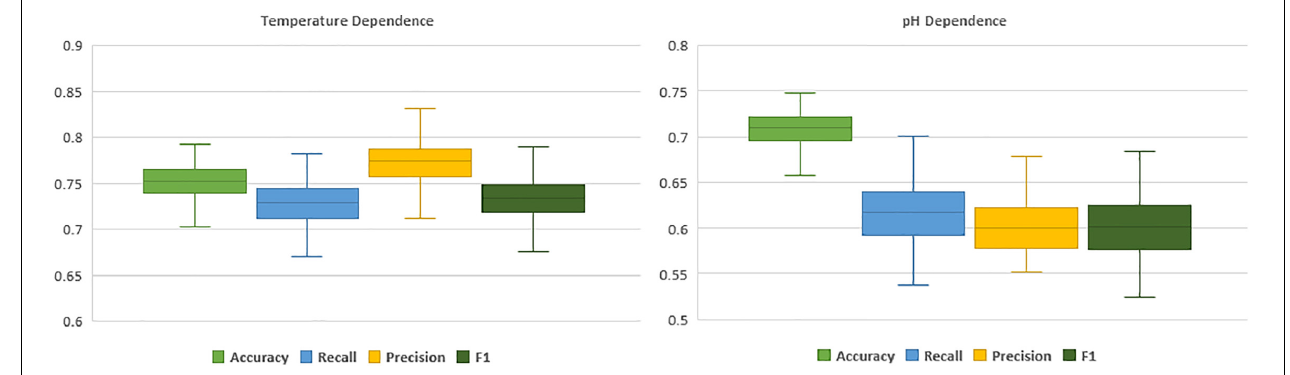
FIGURE 3 | Boxplots of temperature (left) and pH (right) dependence prediction performance computed through 100 sixfold CV tests.